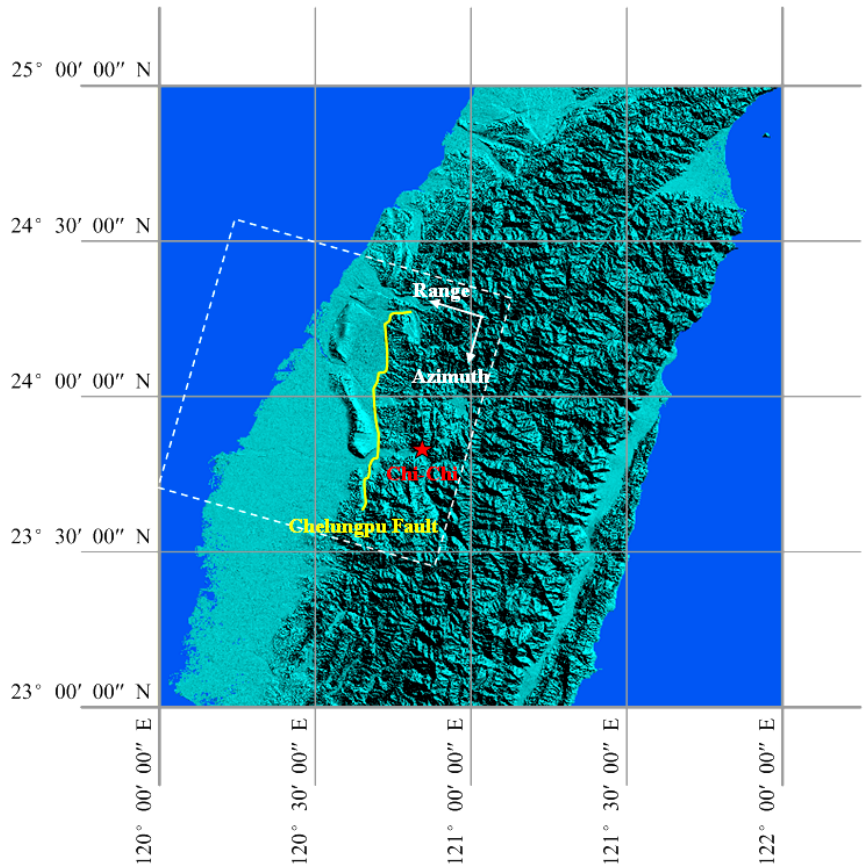
Figure 1. Location of the Chi-Chi earthquake in the WGS 84 system (all figures presented in this paper are in the same reference system except otherwise stated). The red star represents the position of the epicenter. The yellow line represents the Chelungpu fault [7]. The white rectangle indicates the area covered by the ERS-2 descending SAR images used in this